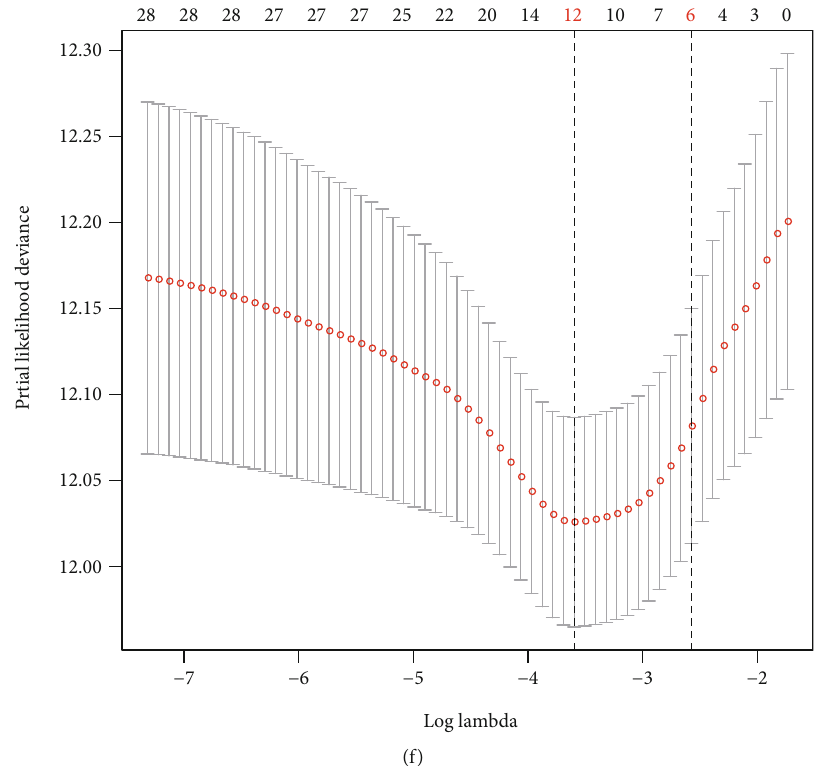
Figure 1: Identi fi cation of prognostic immune-related signatures in melanoma: (a) DEGs in melanoma vs. normal samples; (b) the intersection and di ff erential expression of 91 immune-related signatures; (c, d) functional enrichment analysis revealed the potential immune-related crosstalks associated with prognostic immune signatures; (e, f) LASSO regression analysis was used to identify 12 hub tumor-associated immune signatures. Table 2: Identi fi cation of 12 hub prognostic immune signatures based on a multivariate regression method. Gene